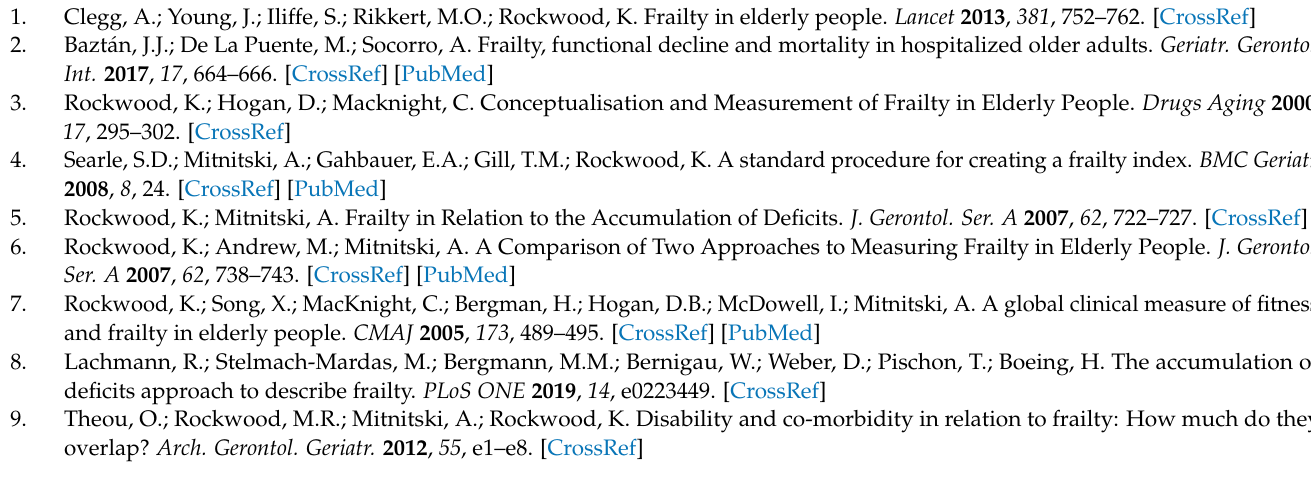
Toilet Walk_out Anorexia 0.52 Walk_out Exercise 0.70 0.93 0 Walk_out Health 0.98 0.75 0 Walk_out Shop 1.00 0.65 0 The arcs with the greatest strength, greater than or equal to 0.8, for both the presence and direction of arcs, correspond to the first 37 (last column with a value of one). The colors in the first two columns represent the classification of nodes: red: Dead ; yellow: AS (Affective Status); light blue: Symptoms; gray: SRH (Self-rated health); green: ADL-IADL (activities of daily living and instrumental activities of daily living); orange: Physical Health; pink: Comorbidities CLD; navy blue: Cognition. Nodes with the presence and direction of arcs strength of 0.8 and more are colored in light green in the third and fourth columns. Nodes only with the presence of arcs strength of 0.8 or more are colored in light orange in the third column. Nodes only with the direction of arcs strength of 0.8 or more are colored in light blue in the fourth